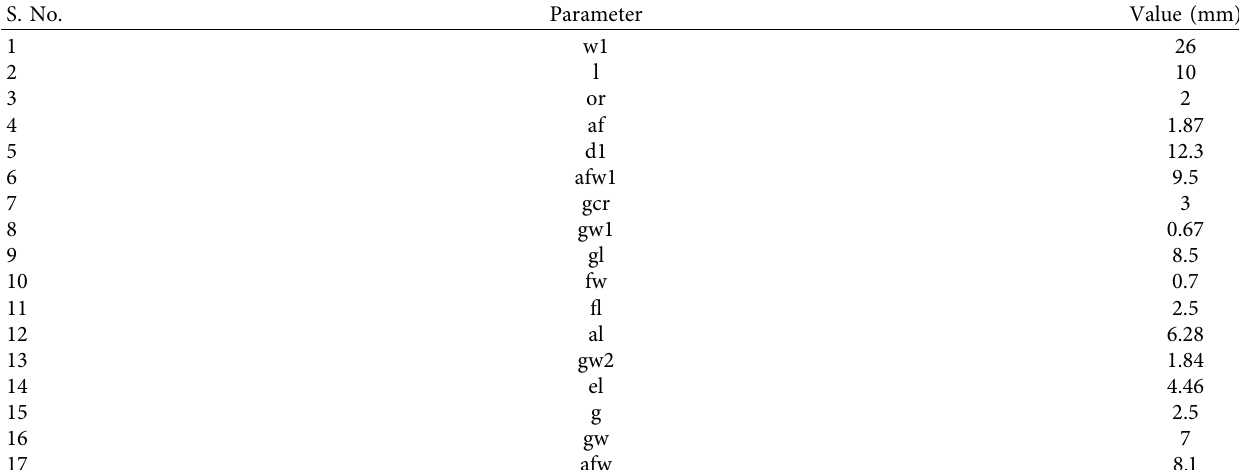
Table 3: Array 3